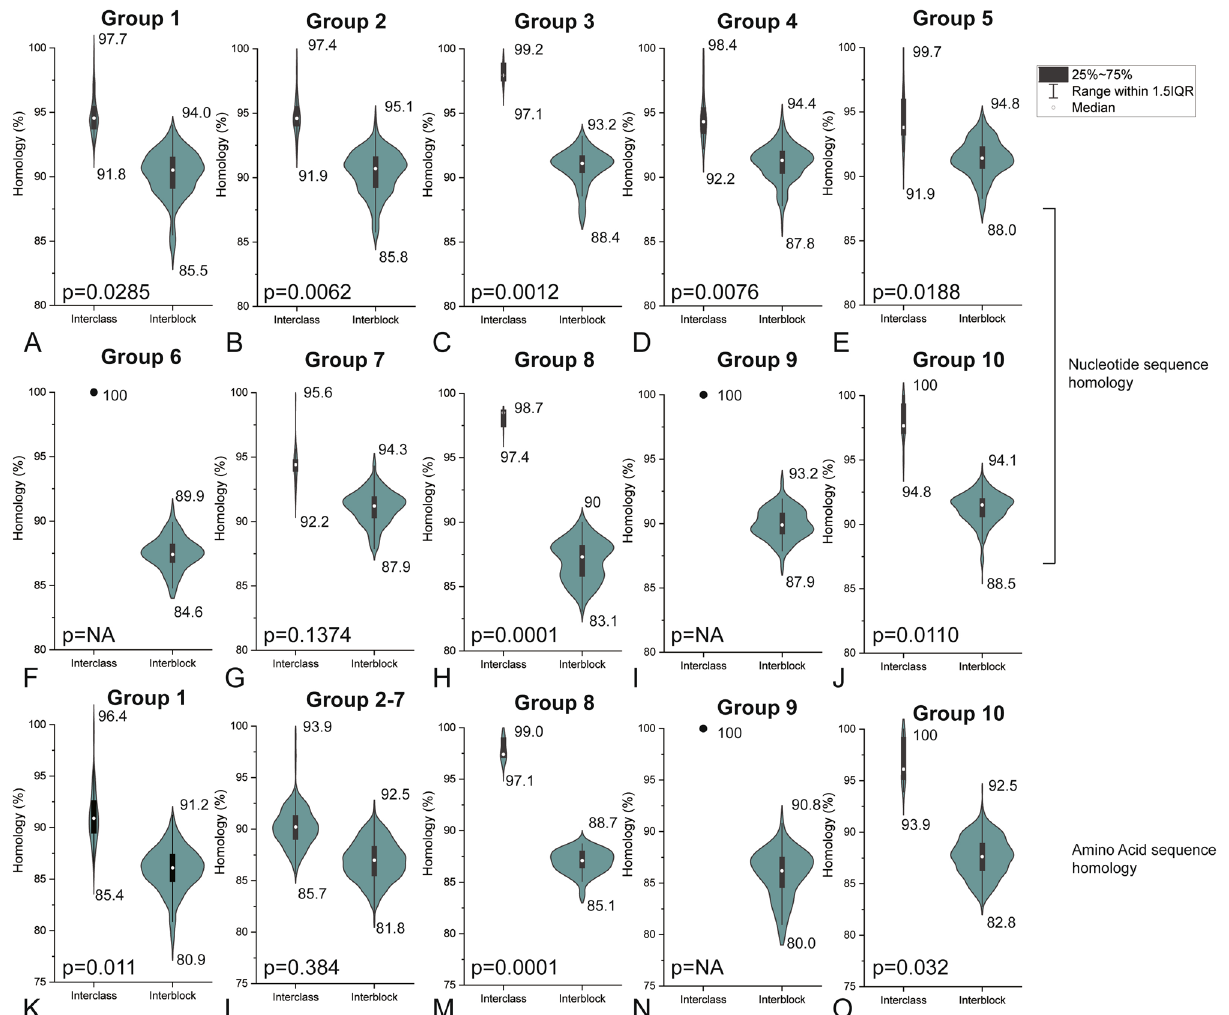
Figure 5. Comparison of interclass and interblock similarity of different groups of ALV-J strains isolated in this study. P value is calculated by t test. NA means not applicable. This image was drawn using GraphPad Prism 7.0.